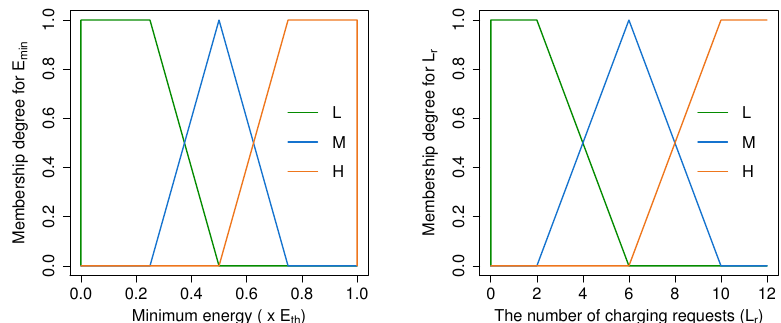
Figure 5. Fuzzy input membership functions.